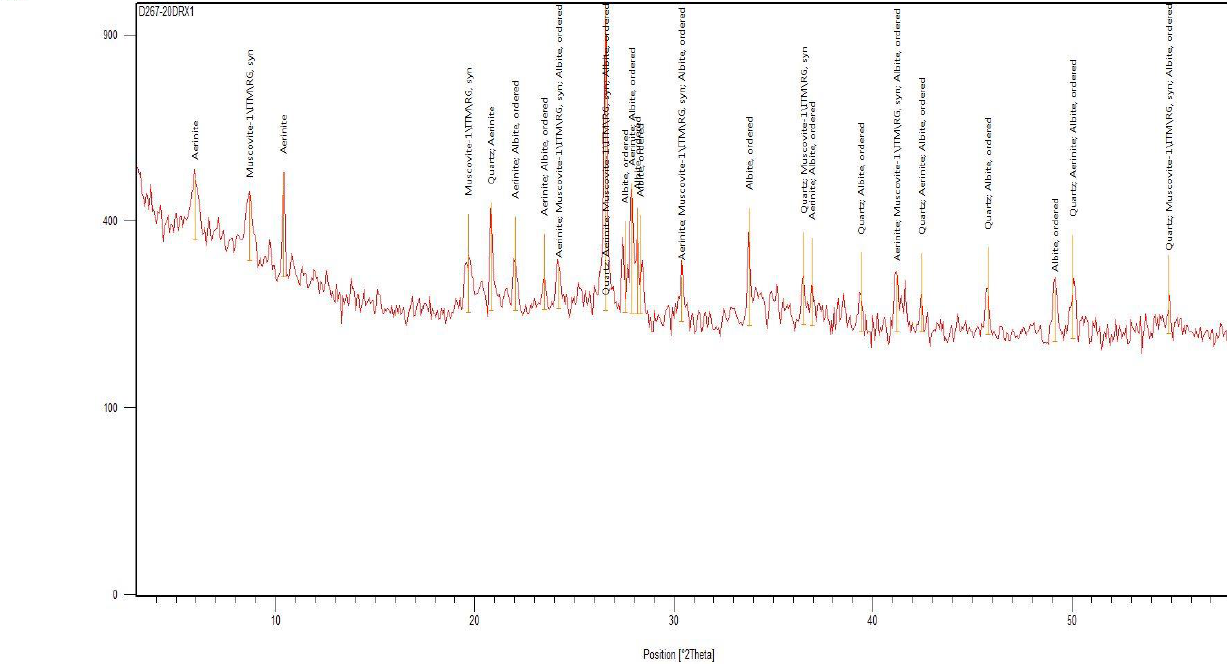
Figure A2. Diffractogram of X-rays on powder of the T1 Figure B1. Diffractogram of X-rays on powder of the T1 sample.